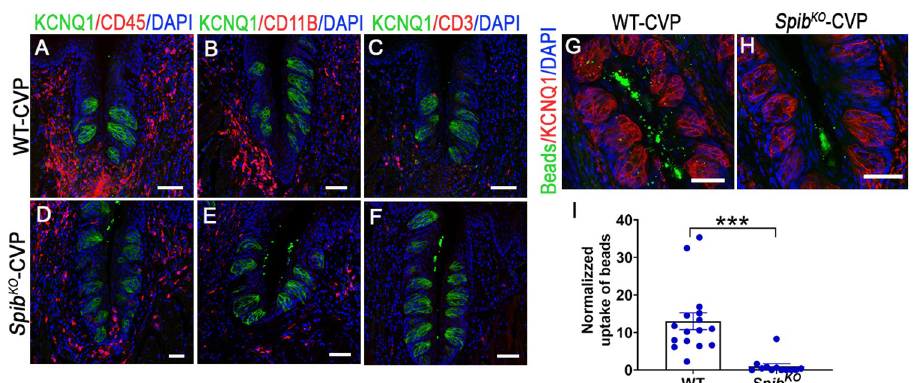
Fig 3. Spib knockout mice have impaired immune responses. ( A - F )Indirect immunofluorescence confocal microscopy of CVP sections from WT and Spib KO mice stained with antibodies against mouse immune cell markers CD45 ( A , D ), CD11B ( B , E ), and CD3 ( C , F ). Compared to WT mice, Spib KO mice had fewer immune cells in the CVP. ( G - H )Uptake of 200-nm diameter fluorescent beads in taste cells from CVP of WT ( G ) and Spib KO mice ( H ) were observed using confocal microscopy. Taste cells are visualized by staining with a pan-taste cell marker KCNQ1 in panels A - H . ( I ) Uptake of beads was quantitated by image analysis and normalized so that the average uptake in WT mice was 1.0. (The data underlying the graphs can be found in Data I in S6_Data.) Compared to WT mice, Spib KO mice took up fewer beads. ��� p < .001. Scale bars, 50 μ